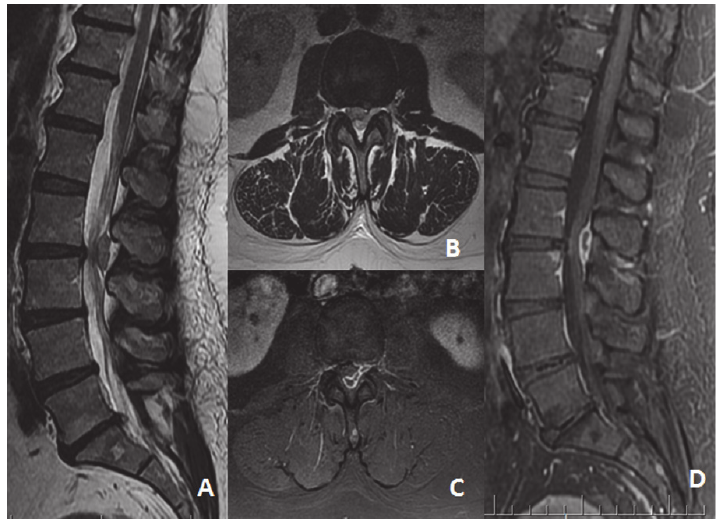
Figure 1: Preoperative MRI scan showing (A) sagittal, (B) axial T2W, (C) axial, and (D) sagittal gadolinium enhanced sequences showing the L2-L3 complete disc extrusion with an anterior-to-posterior circumferential course of the sequestered disc.